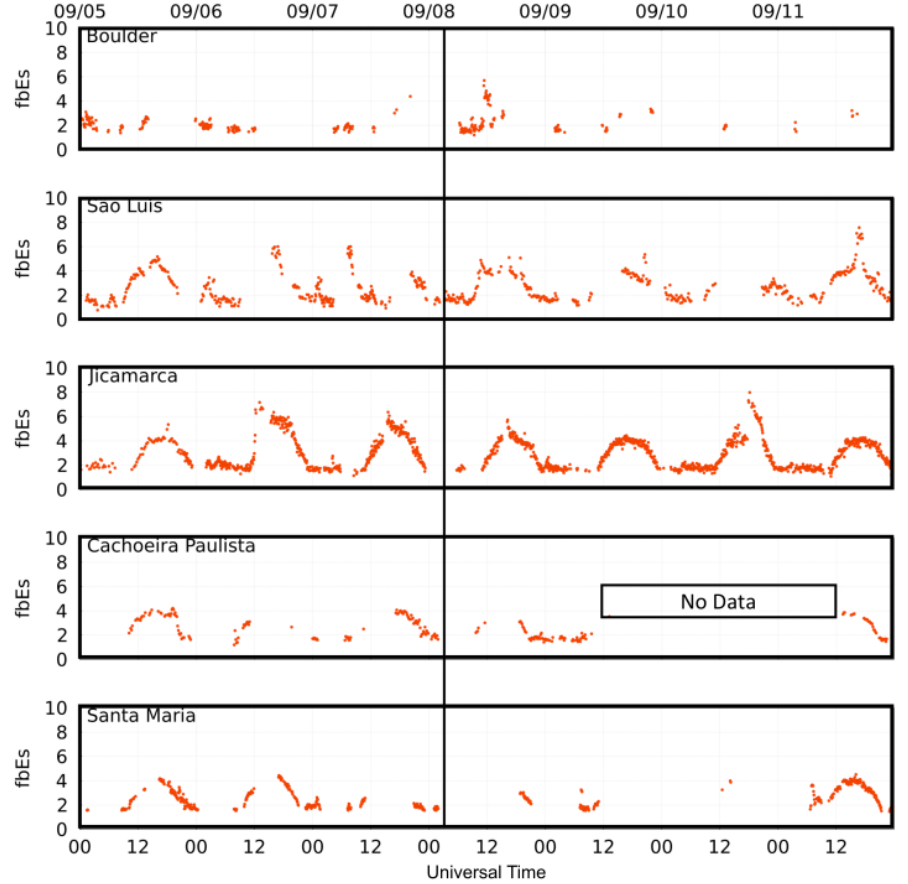
Figure 3. The fb Es parameter (red symbols) from top to bottom: Boulder, São Luís, Jicamarca, Cachoeira Paulista, and Santa Maria on 5–11 September 2017.